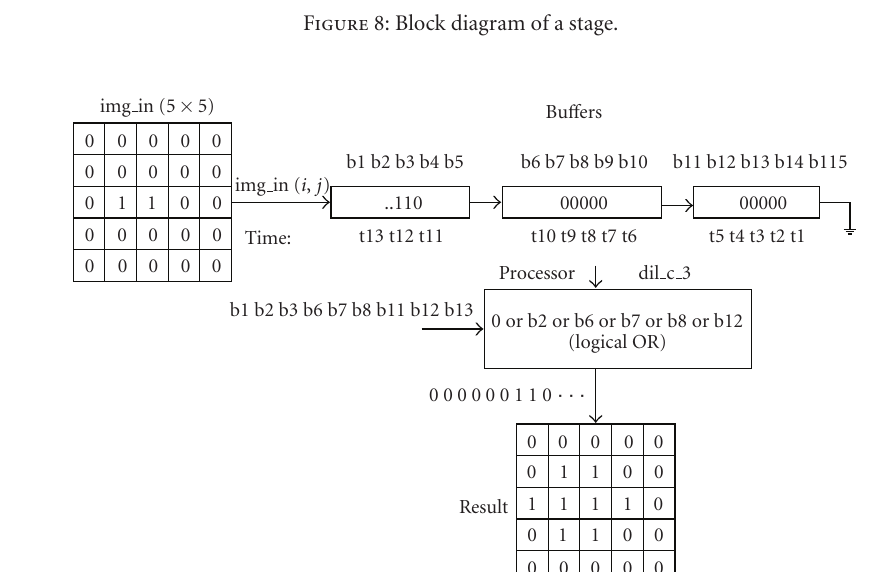
Figure 8: Block diagram of a stage.